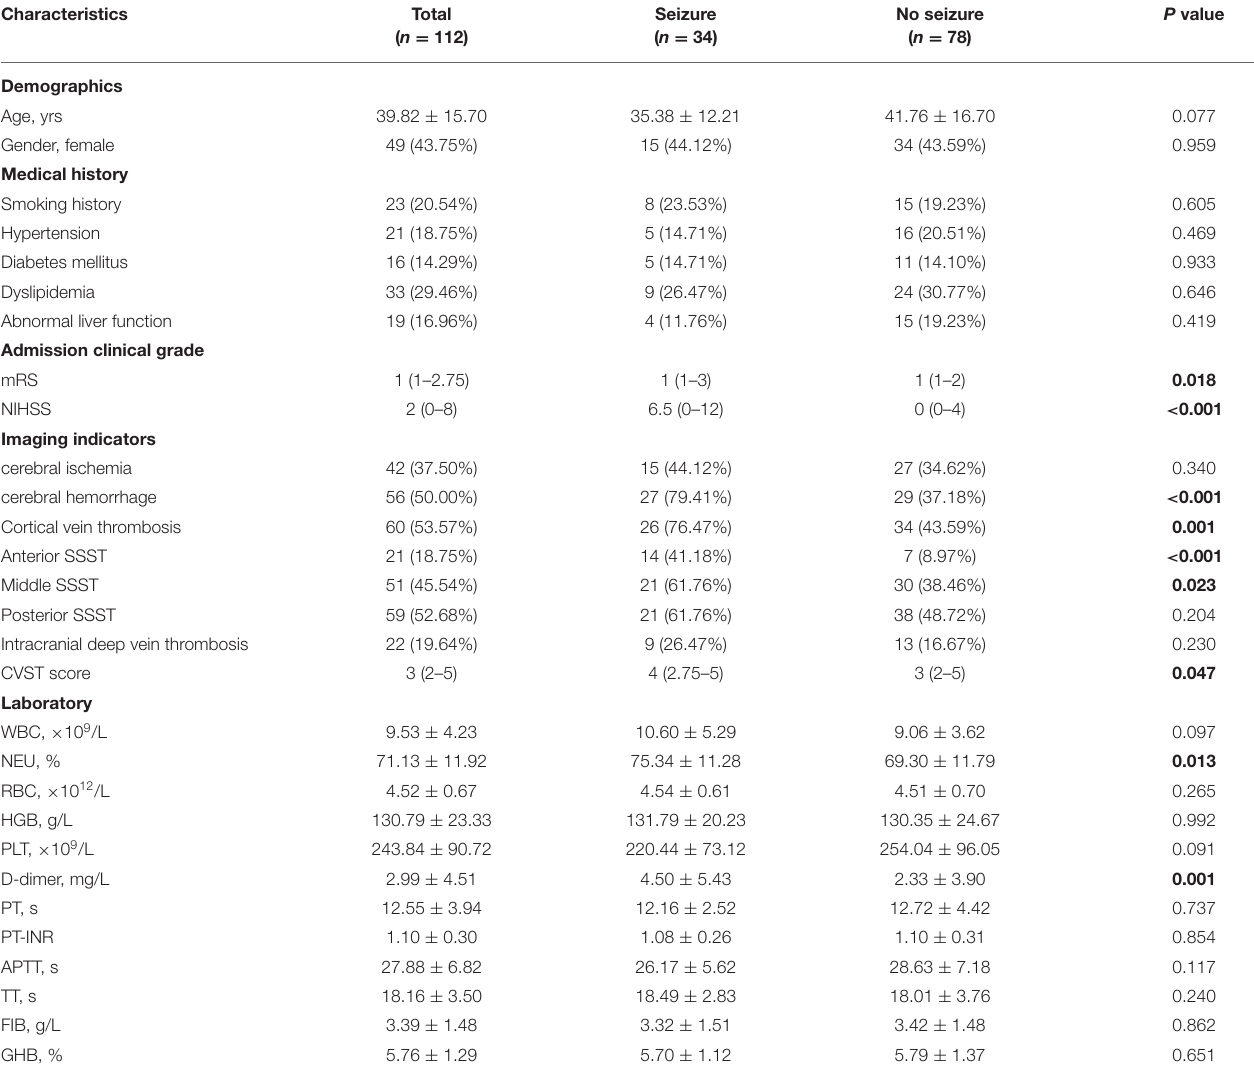
TABLE 1 | Demographic features and clinical characteristics of CVST patients with and without early-onset seizures.